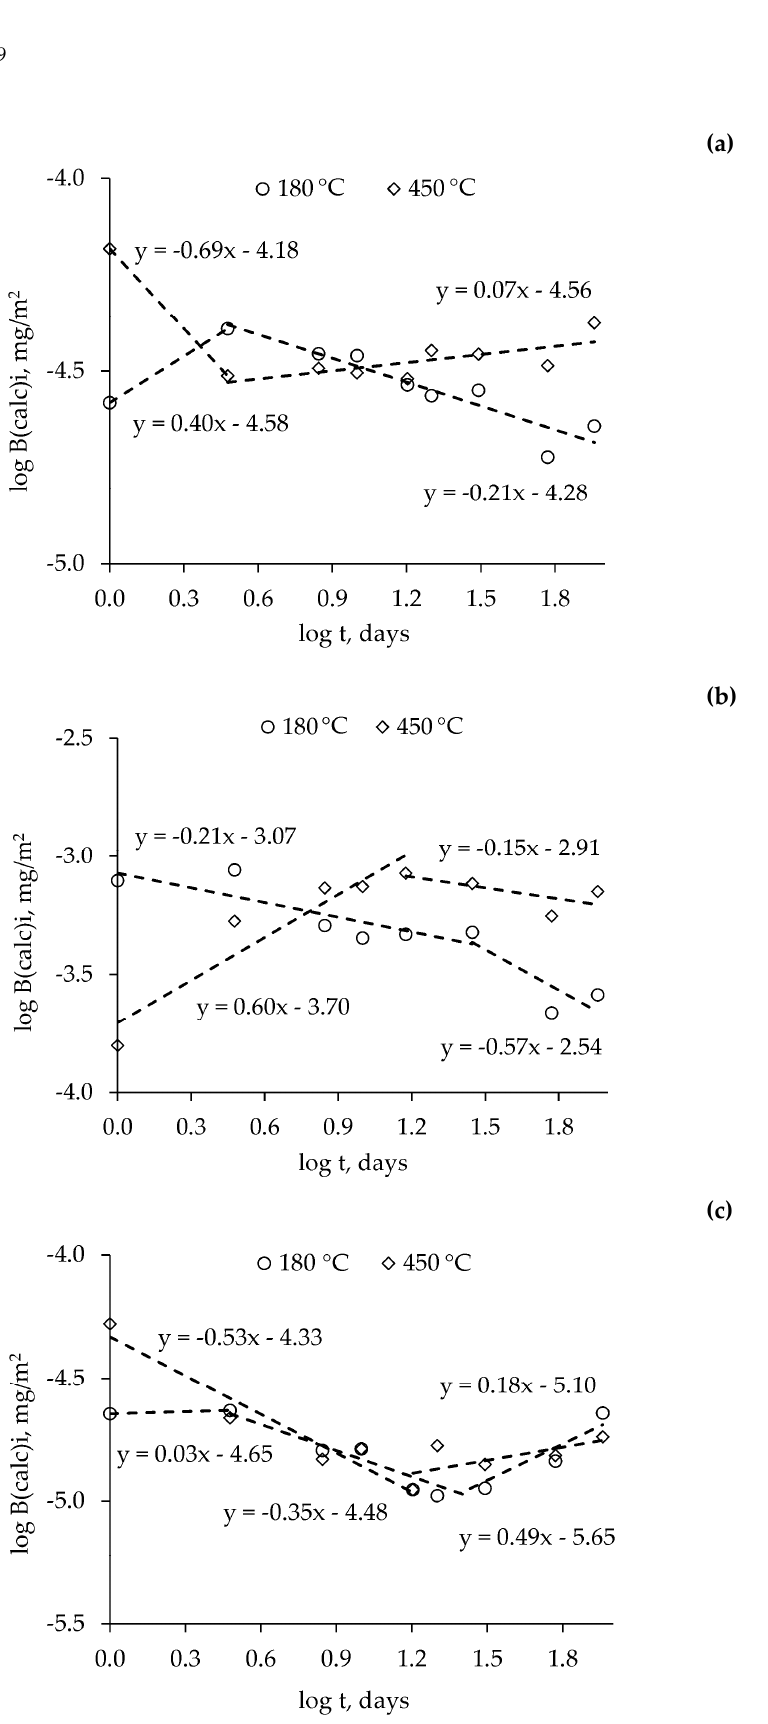
Figure 7. Logarithmic dependence of the 137 Cs release from MPP-NZ ( a ), MPP-STA-NZ ( b ), and MPP-MOR ( c ) compounds on contact time with water.